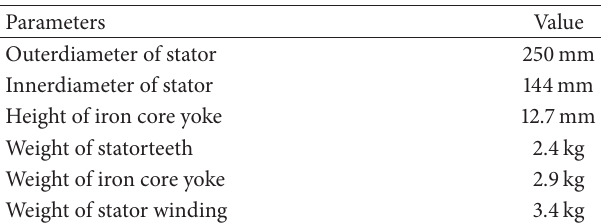
Figure 6: Excitation signal imposed on stator system. Table 3: Parameters of stator system of 15 kW motor.